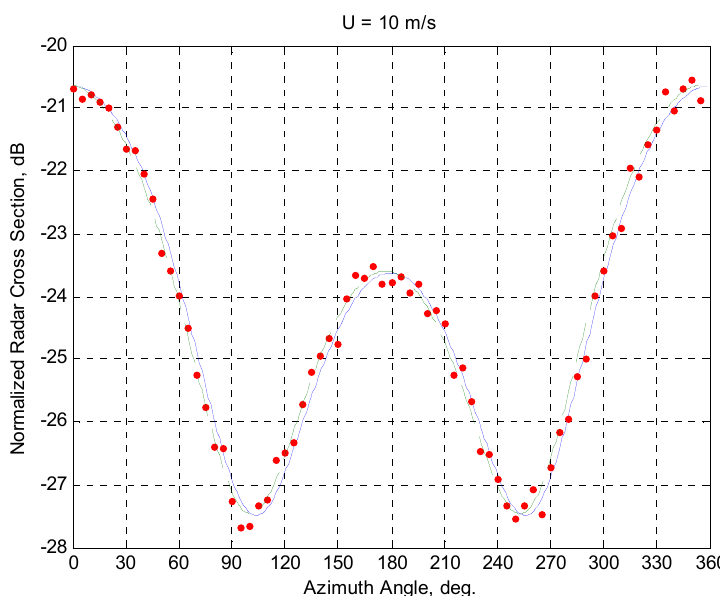
Figure 6. Azimuth NRCS curve by model Equation (1) at the incidence angle of 45°, “true” wind speed of 10 m/s and “true” up-wind direction of 0° (solid line); generated “measured” NRCS with taking into account the instrumental noise of 0.2 dB after the averaging of 1565 samples in a five-degree azimuth sector (red dots); and azimuth NRCS curve by model Equation (1) corresponding to “measured” wind speed of 10.0258 m/s and up-wind direction of 356.9° retrieved from the azimuth sector of [45°, 225°] (dashed line).